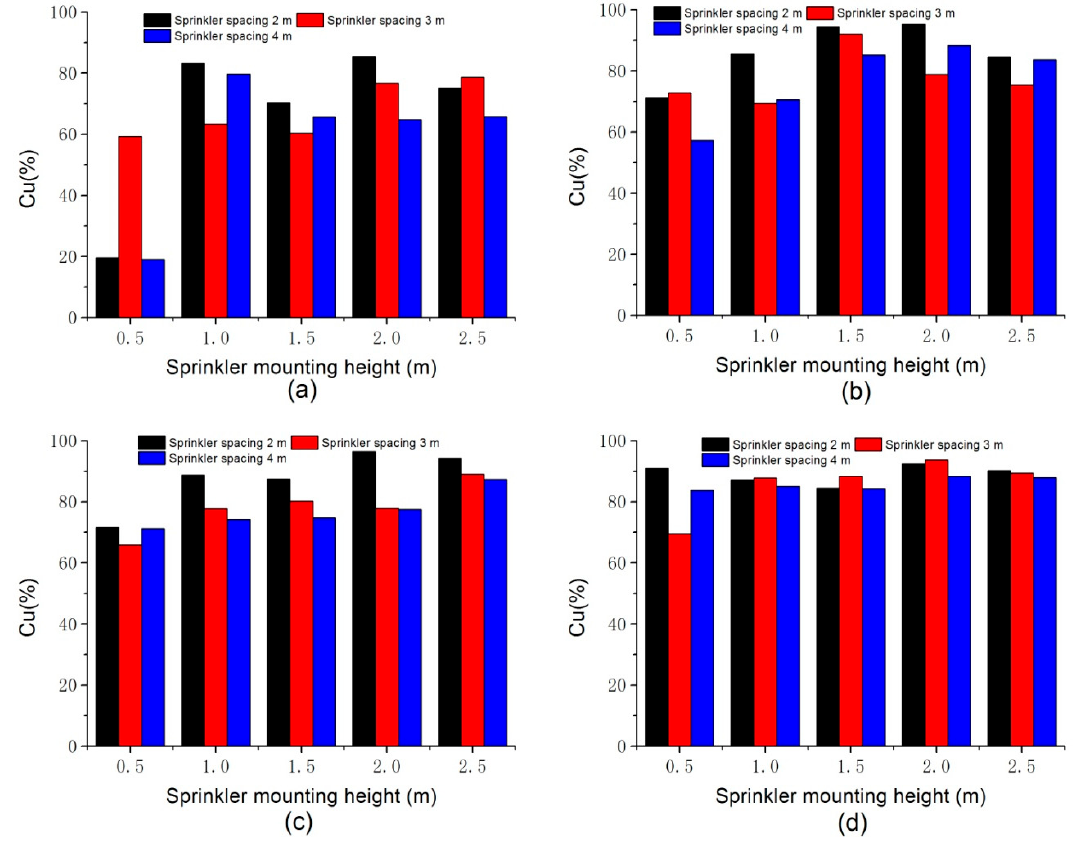
Figure 14. Calculated Cus as a function of mounting height and sprinkler spacing for different working pressure: ( a ) 50 kPa, ( b ) 100 kPa, ( c ) 150 kPa, ( d ) 200 kPa.